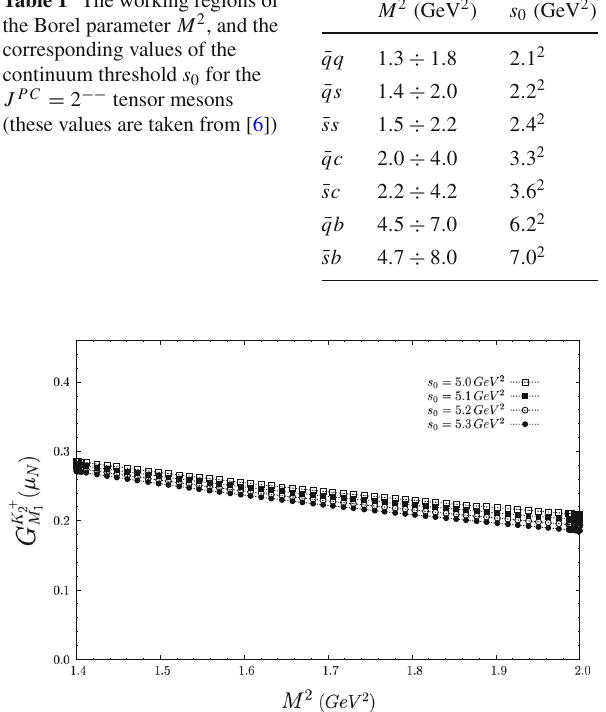
Using the values of the input parameters and the work- ing regions of M 2 and s 0 , the values of the magnetic dipole moments can be determined. As n example, in Figs. 1 and 2 we present the dependence of the magnetic dipole moments + and D 0 mesons on M 2 at several fixed values of s 0 , of K 2 2 respectively. It follows from these figures that the magnetic dipole moments show a weak dependence on M 2 in its work- ing region. Similar analysis for the other J PC = 2 −− tensor mesons are carried out whose results are presented in Table 2.